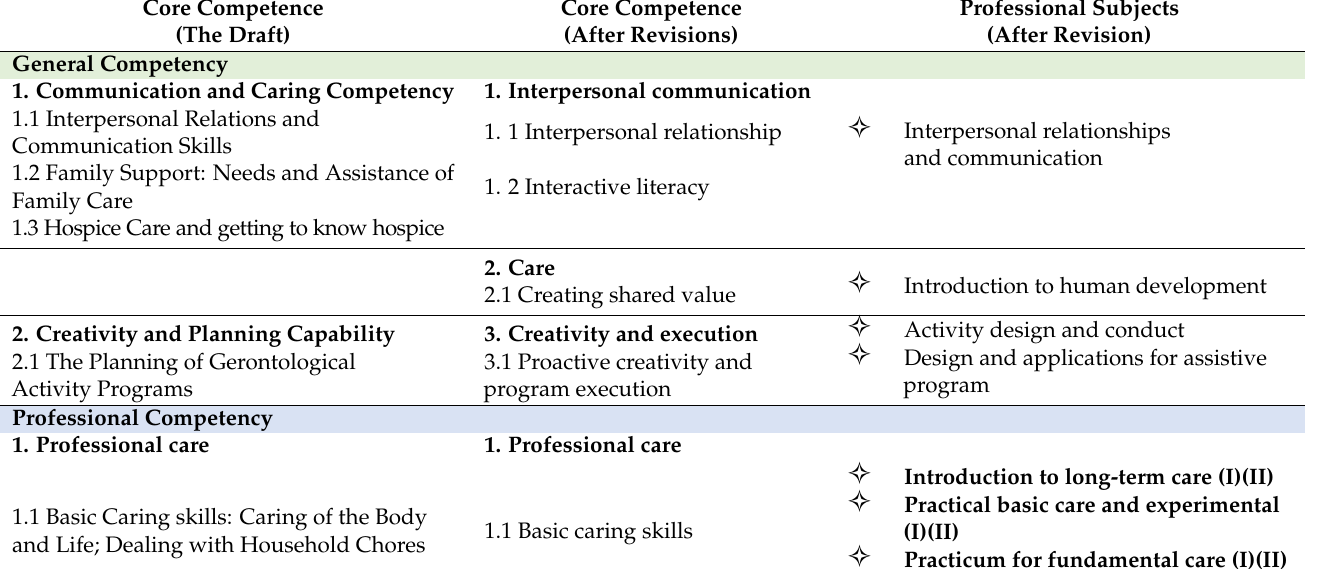
Table 2. Revision Reference Table of Core Competences and Professional Curriculum after Focus